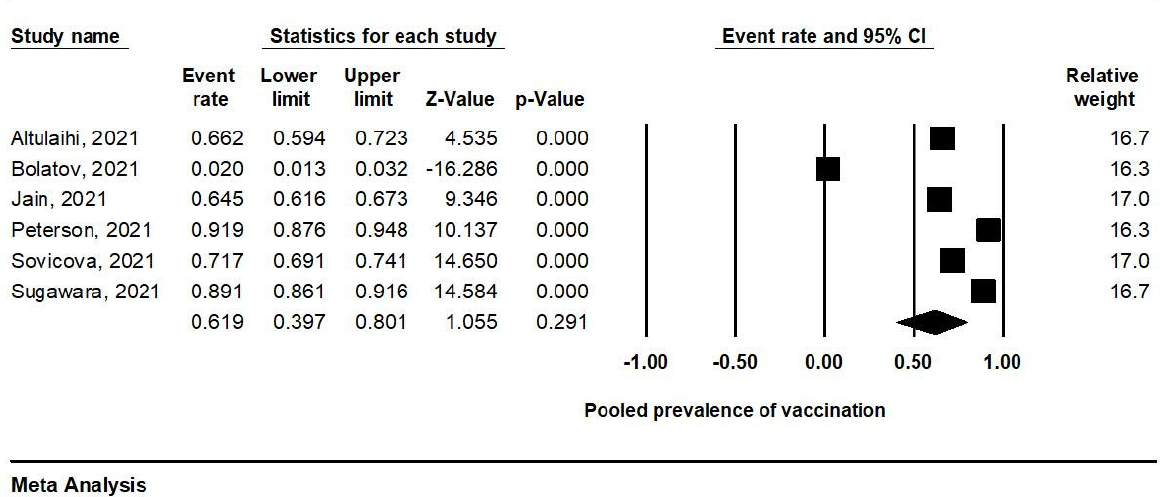
Figure 2. Forest plot of vaccination prevalence.